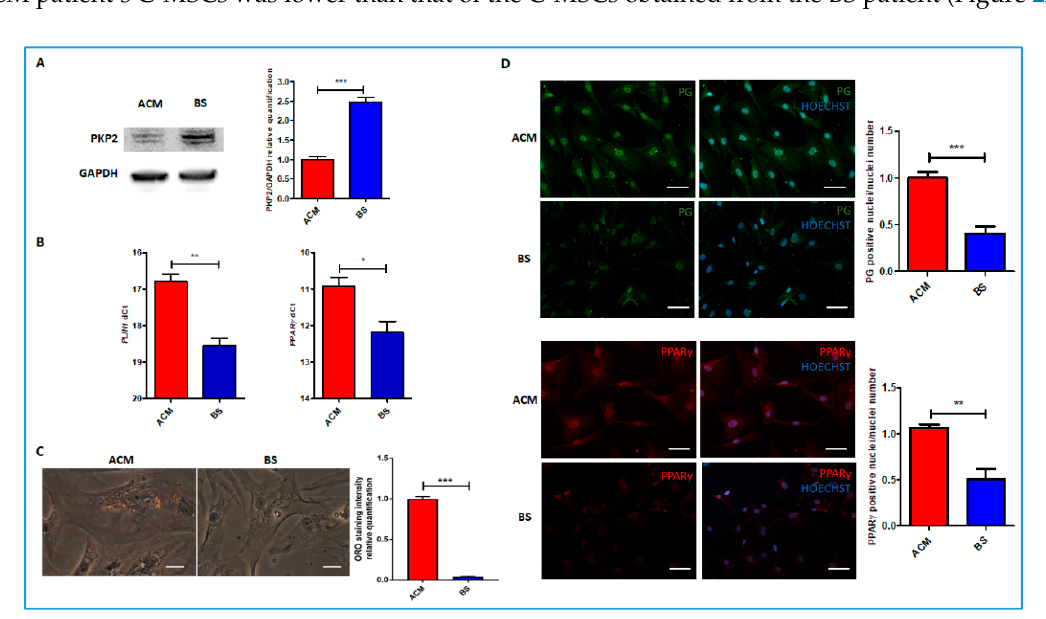
Figure 2. C-MSC data are distinctive of ACM. ( A ) Western blot shows higher PKP2 expression in ACM than in BS C-MSCs cultured in basal condition. GAPDH is shown as a loading control and used to normalize the quantification. ( B ) qRT-PCR data showing higher PLIN1 and PPAR γ expression in ACM than in BS C-MSCs in adipogenic medium. ( C ) Higher ORO staining is detected in ACM vs. BS C-MSCs cultured in adipogenic medium for three days, as in the representative image and quantification. Scale bar is 20 μ m. ( D ) Representative immunofluorescence images of C-MSCs cultured in adipogenic medium for three days and stained with PG or PPAR γ antibodies. More positive nuclei/nuclei numbers were observed in ACM than in BS cells for both markers. Scale bar is 50 μ m. The graphs show the mean and standard error of three technical replicates. * p < 0.05; ** p <